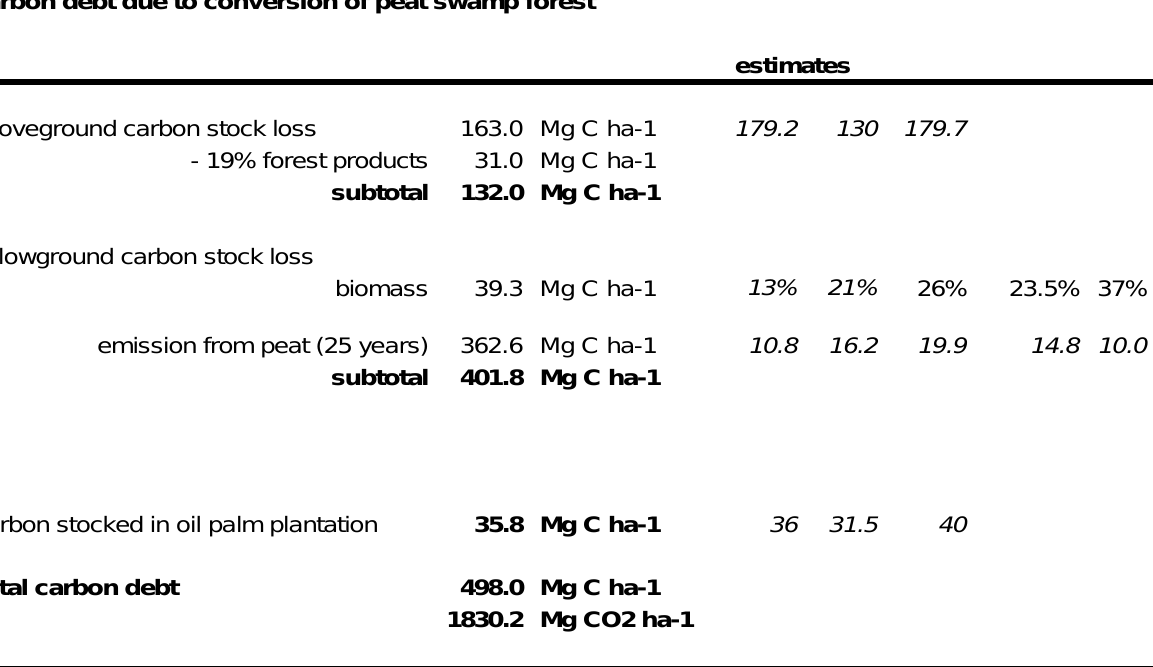
Table A2.2. Carbon debt calculation of the Kubu Raya, West Kalimantan, Indonesia